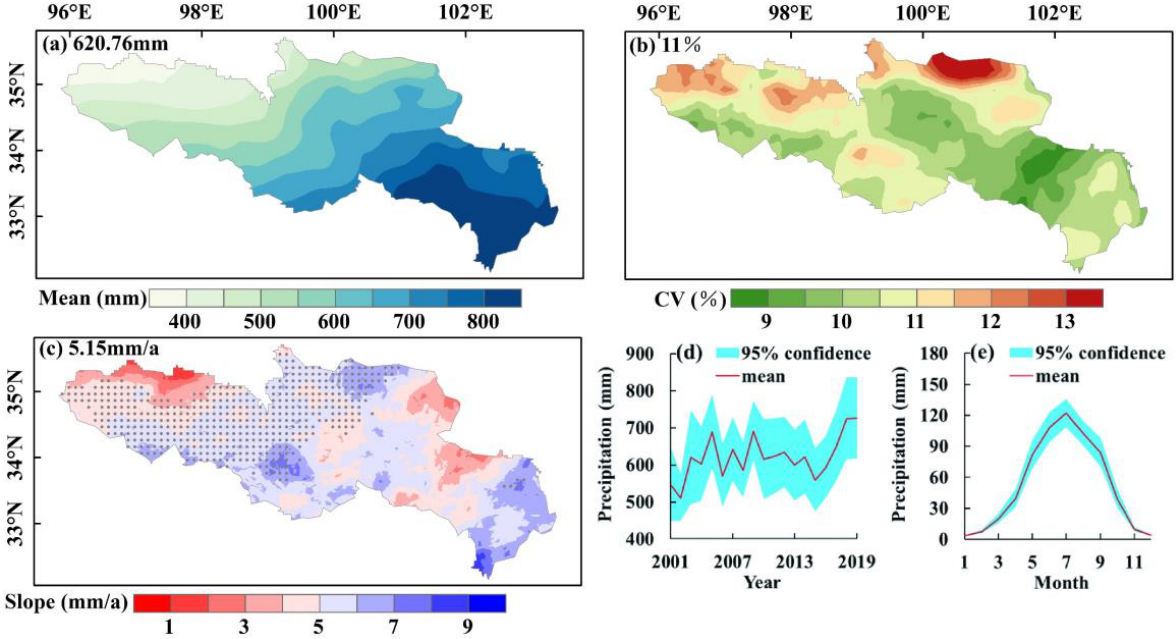
Figure 11. Annual average precipitation ( a ), coefficient of variation ( b ), the spatial distribution of annual variation trend ( c ), annual precipitation sequence ( d ), and monthly precipitation variation characteristics ( e ) across the SRYR simulated by OBIPP. The OBIPP of this study is GEPC+. Figure 12a shows the spatial distribution, uncertainty, and change trend of runoff simulated by OBIPP across the SRYR. The annual average runoff depth across the SRYR presents a spatial distribution similar to precipitation, showing an increasing spatial pattern from northwest to southeast, from more than 160 mm to less than 40 mm. The uncertainty of runoff depth is mainly concentrated in the northwest of the SRYR, with a variation coefficient of more than 20% (Figure 12b). During 2001–2019, the average runoff depth across the SRYR was 63.50 mm, with a fluctuation interval (95% confidence interval) of 42–84 mm; The runoff depth generally shows an increasing trend, about 0.71 mm/a, while the runoff depth in the southeast increases with a trend of more than 1.6 mm/a (Figure 12c,d). The runoff depth across the SRYR is similar to the precipitation, with noticeable seasonal differences. The high value of runoff depth is concentrated in summer. The average runoff depth from May to September is higher than 11 mm/month, while the average runoff depth from October to April is lower than 2 mm/month (Figure